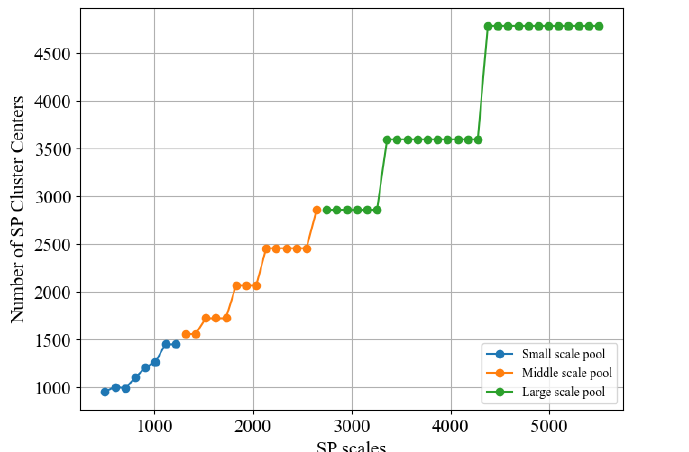
Figure 3. The number of cluster centers corresponding to different SP scale maps obtained by SLIC on University of Pavia. The same number of cluster centers means the same segmentation map.